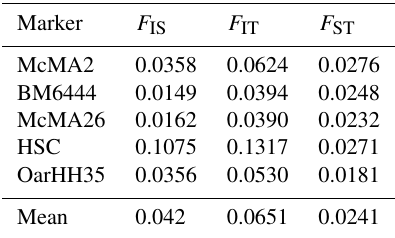
Table 5. Estimators of F statistics at each locus across the 14 sheep types. Marker F IS F IT F ST